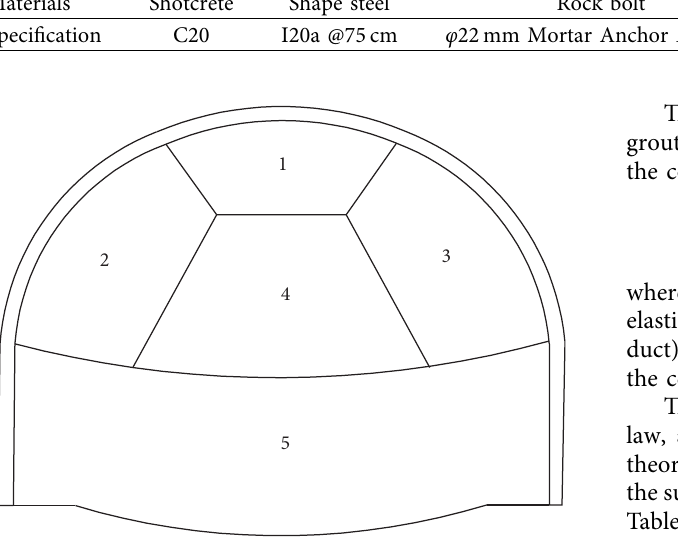
Figure 4: The construction process of reserved core